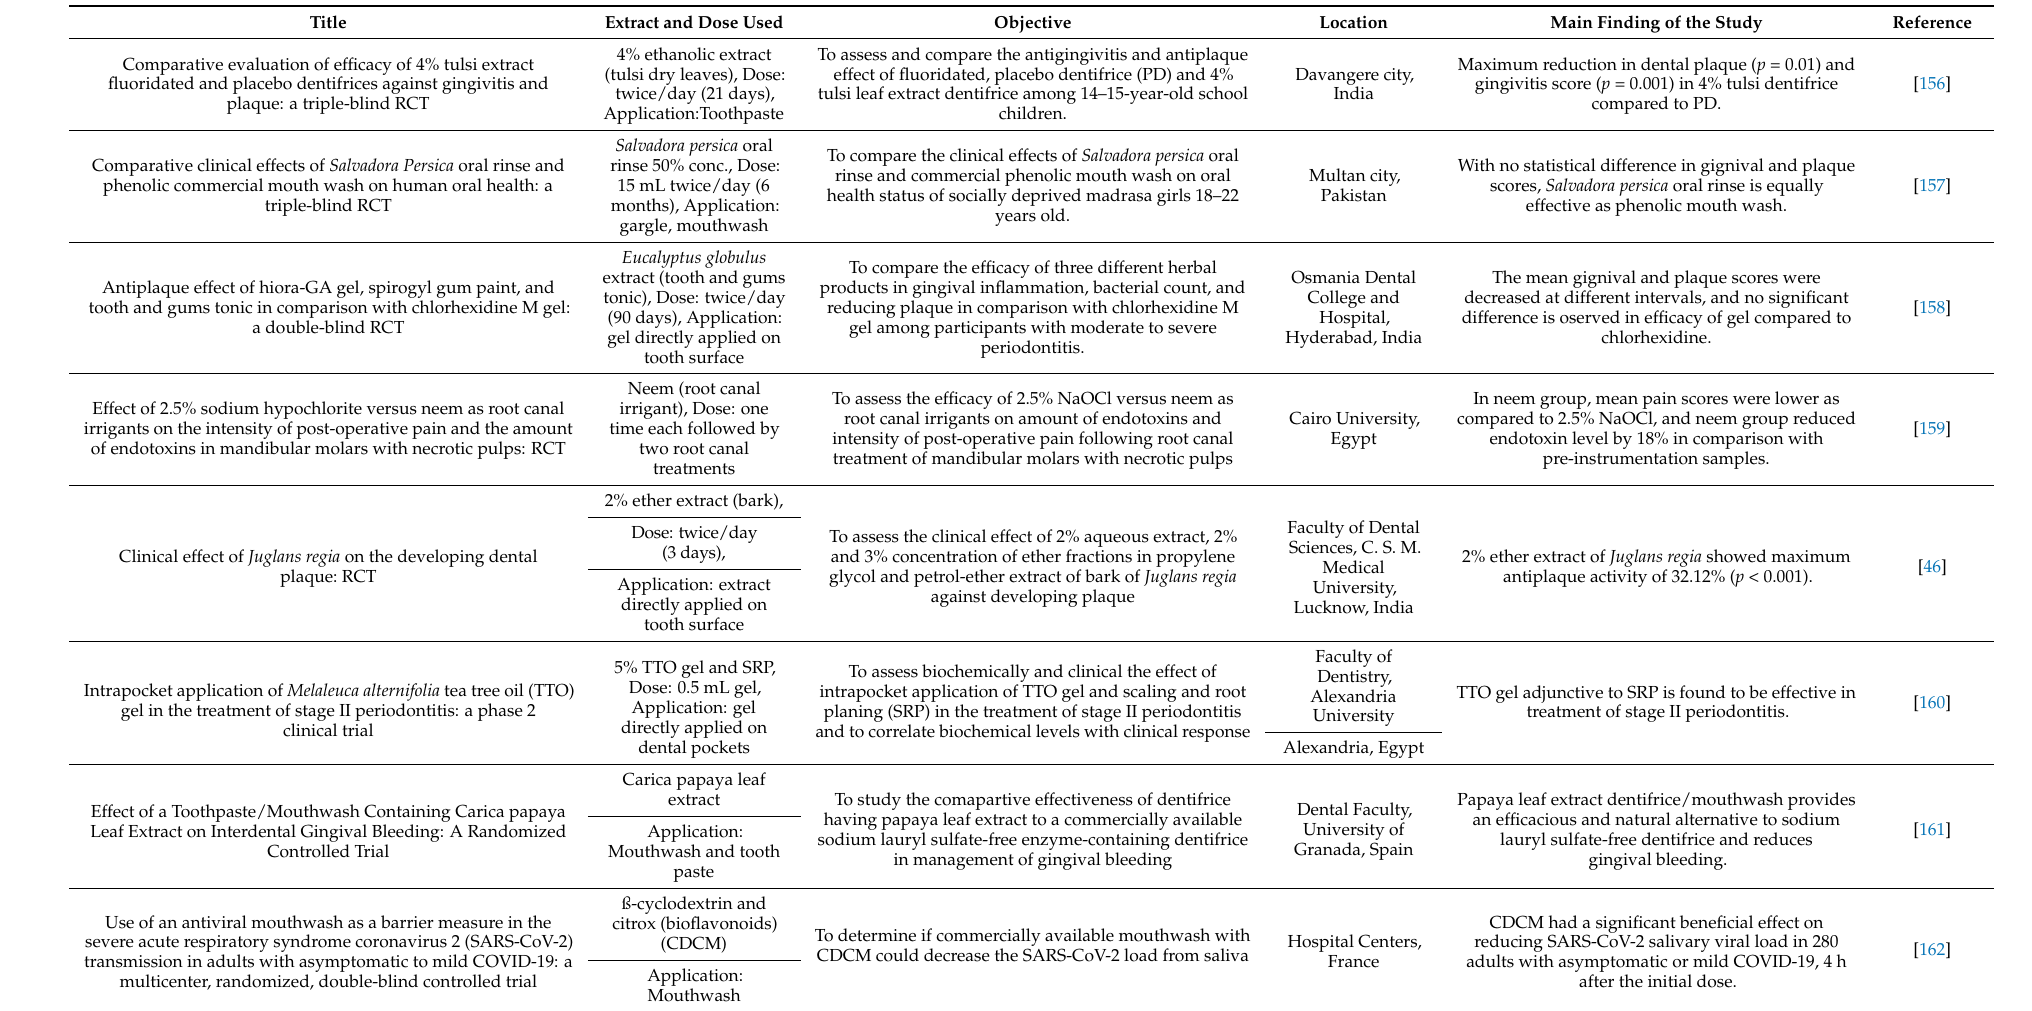
Table 3. Clinical trials on the effect of antioxidant extracts from medicinal plants in oral